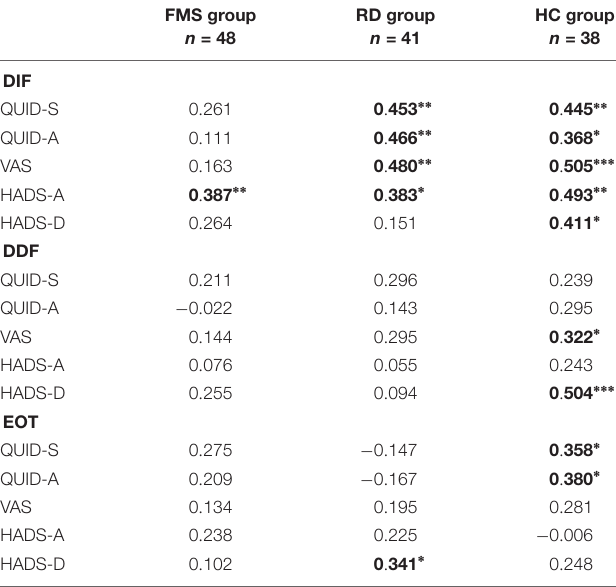
TABLE 3 | Significant Spearman correlation coefficients: associations between alexithymia and questionnaire scores in patients with fibromyalgia (FMS), rheumatic diseases (RD) and healthy subjects